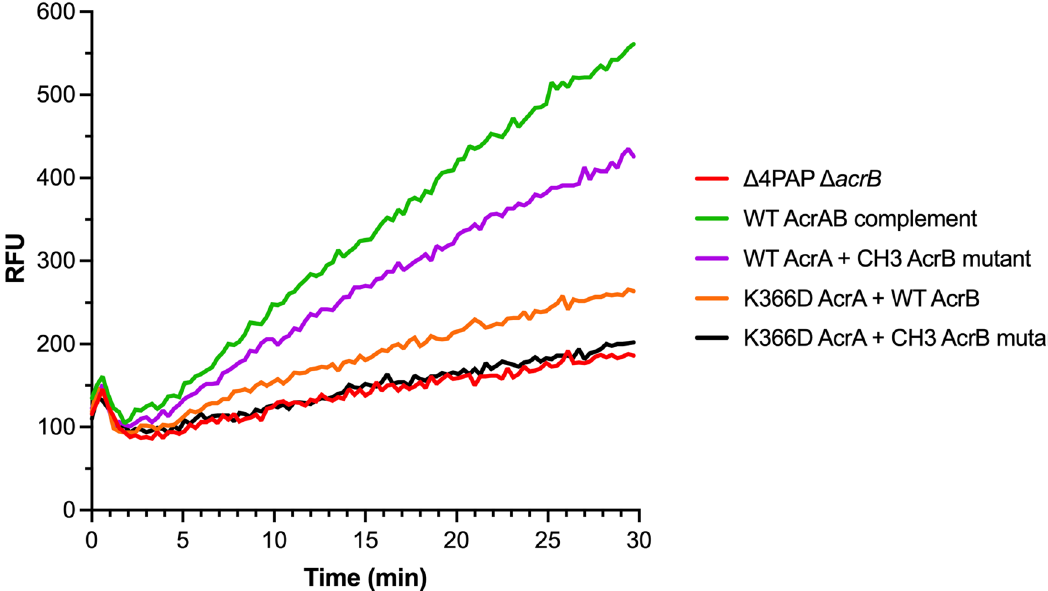
Figure 8. Efflux of doxorubicin over time in the Salmonella Typhimurium SL1344 Δ4PAP Δ acrB strain complemented with K366D AcrA and the AcrB channel 3 (CH3) mutation. Bacteria were treated with doxorubicin and the proton-motive force dissipater CCCP for 1 h and then re-energised with glucose. Efflux was monitored by increasing RFU due to extracellular doxorubicin. Data presented are the mean of three biological replicates. AcrB CH3 mutation refers to A33W T37W N298W